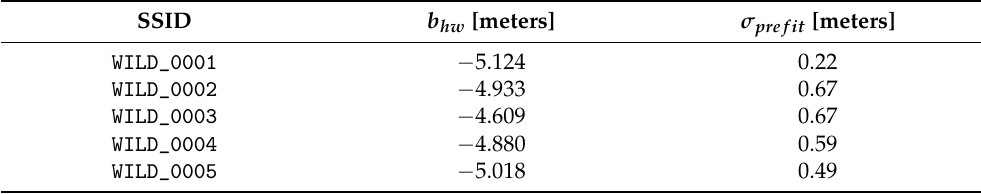
Figure 2. Prefit residuals of the RTT measurements (observed by the smartphones placed at CP minus the true distance). Table 3. The estimated hardware biases (in meters) using the true positions of the Access Points and smartphone positions (surveyed with a Septentrio AsteRx GNSS recever). Both the estimated hardware bias as well as the precision of this estimation is shown in the table for each